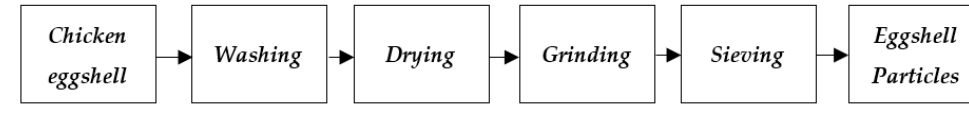
Figure 2. Processing for uncarbonised eggshell